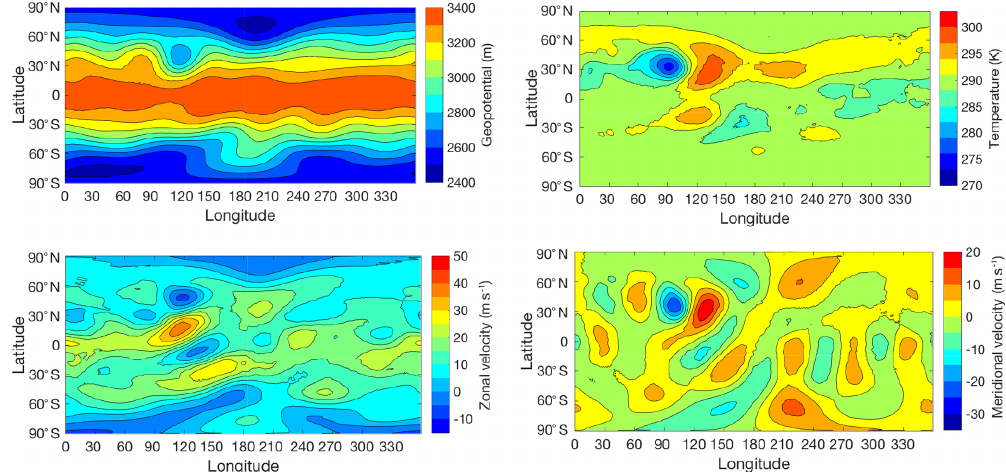
Figure 7. Latitude–longitude projections at 700hPa of the adaptive simulation of the mountain-induced Rossby wave test case at day 25.